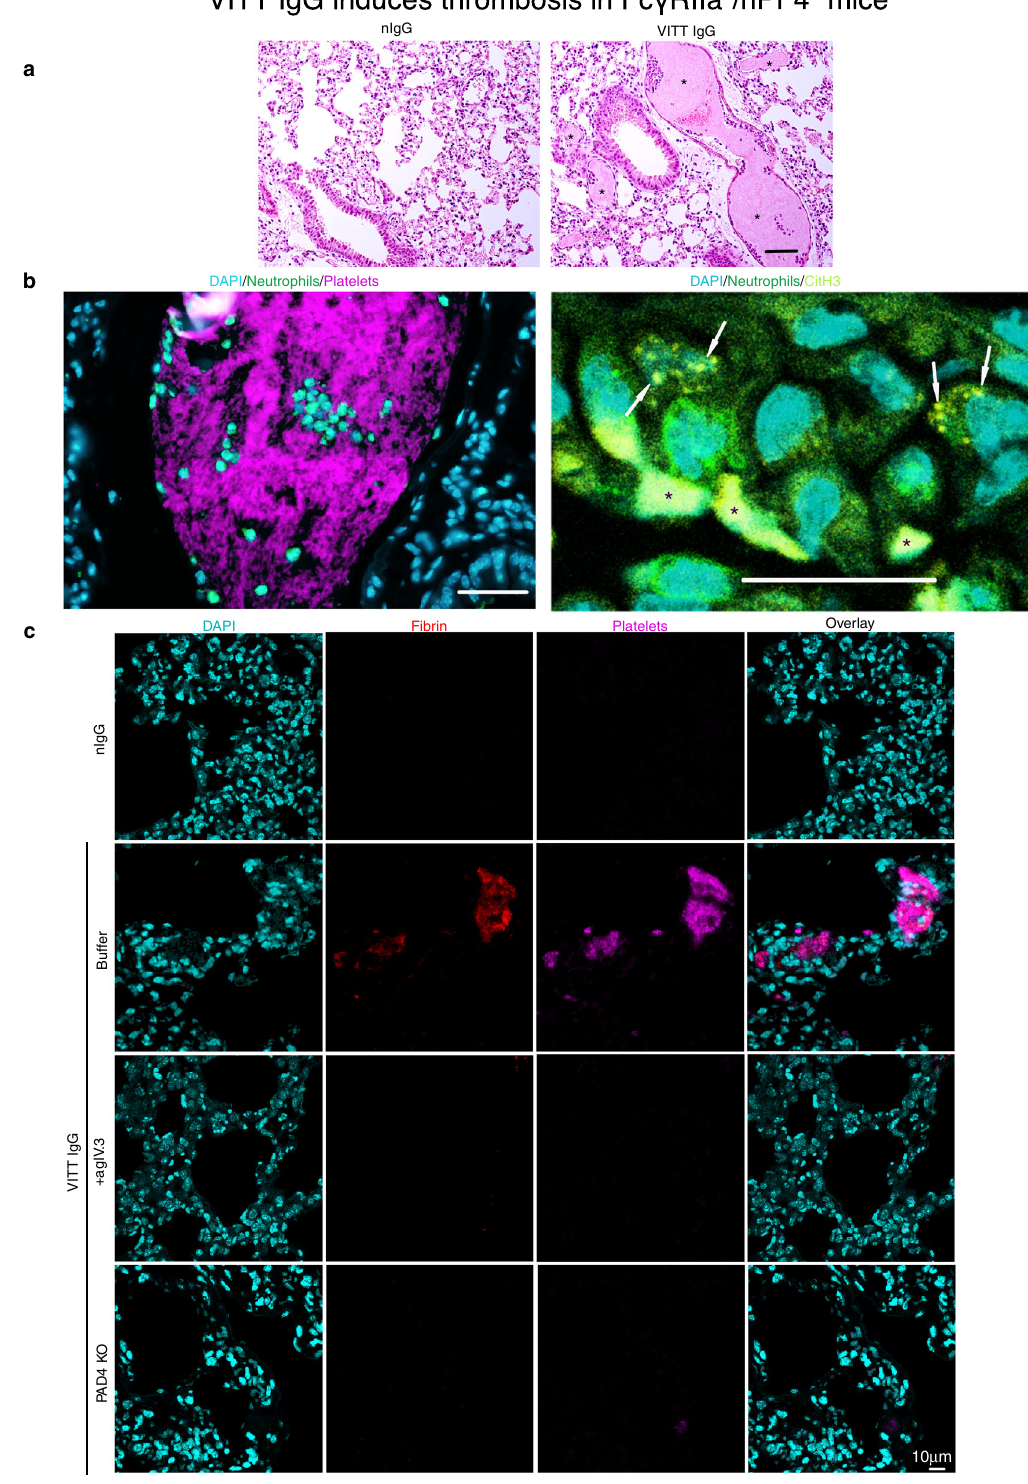
Fig. 3 | VITT IgG induces thrombosis in Fc γ RIIa + /hPF4 + mice. a Representative H&E staining of lung sections of mice treated with nIgG or VITT IgG. Scale bar 50 μ m. b Fluorescent images of lung sections of mice treated with VITT IgG. Pla- telets and CitH3 were labelled in vivo with anti-CD42c-Dylight 649 (magenta) and AF594 (yellow). Neutrophil were stained with anti-Ly6G (green). Neutrophil in fi l- trationinthe clotisshown. CellnucleiwerestainedwithDAPI(blue). Whitearrows indicateareasofCitH3staining.Asterisksindicateauto fl uorescencefromredblood